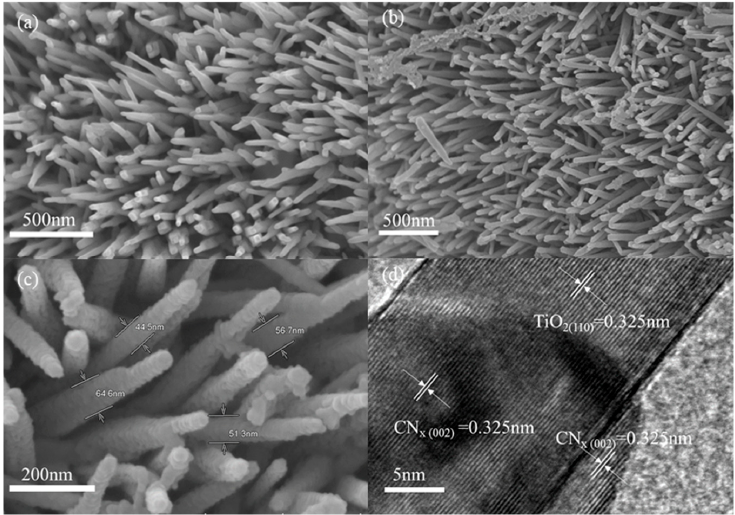
Figure 3. SEM images of ( a ) TiO 2 nanowire arrays and ( b , c ) CN x /TiO 2 core-shell nanowire arrays, ( d ) HRTEM image of CN x /TiO 2 ore-shell nanowire arrays. ( d ) HRTEM image of CN x /TiO 2 ore-shell nanowire